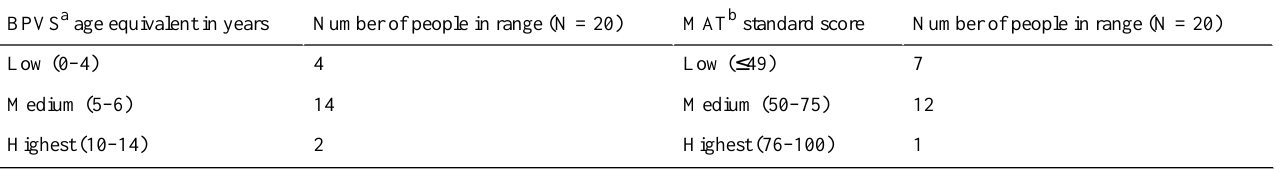
Table 1. Levels of cognitive function within the sample of people with intellectual